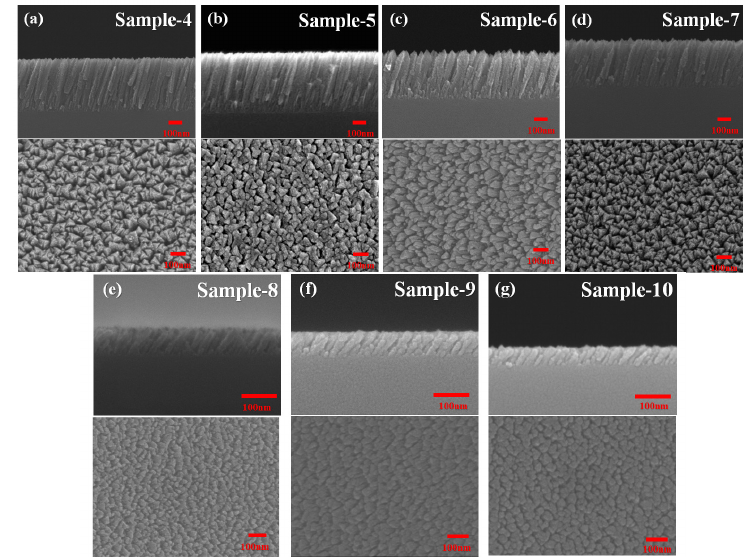
Figure 5. Top-view and cross-section scanning electron microscopic (SEM) images of TiN nanorod arrays (NRAs) deposited at α of ( a ) 75°, ( b ) 80°, ( c ) 85°, ( d ) 88° without flux collimation and at α of ( e ) 80°, ( f ) 85°, ( g ) 88° with flux collimation.